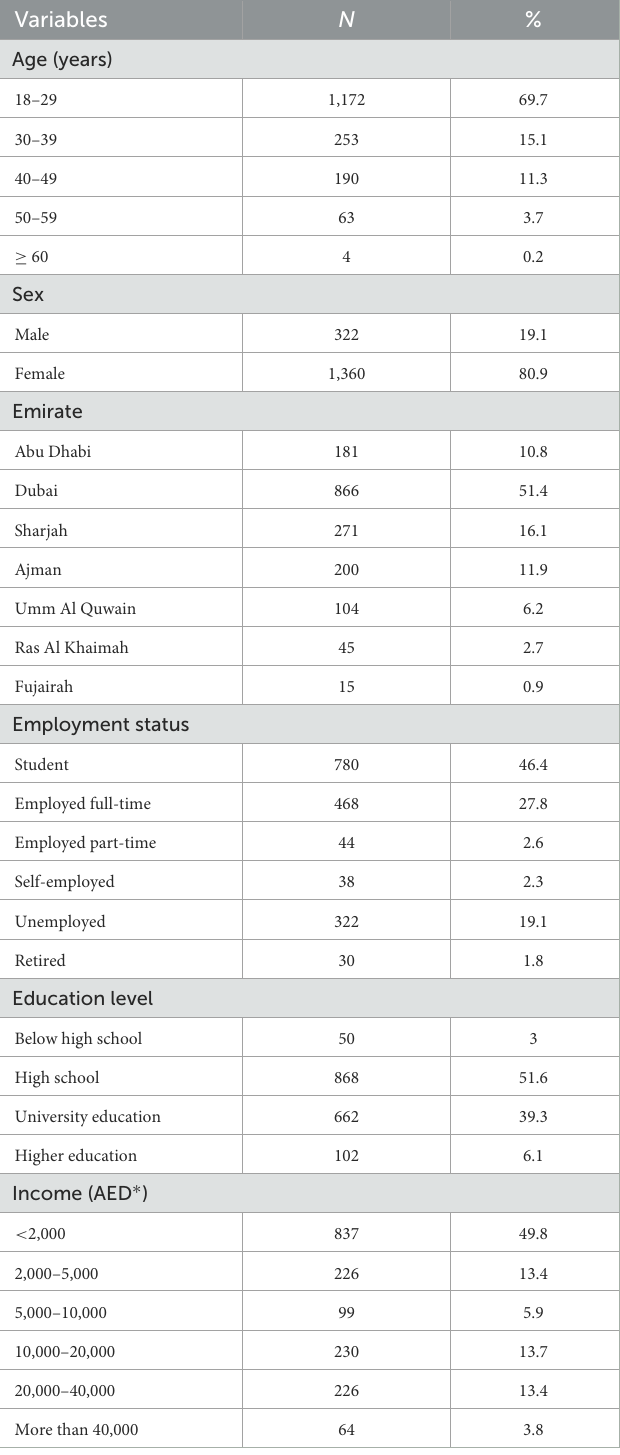
TABLE 1 General characteristics of the study participants ( n =